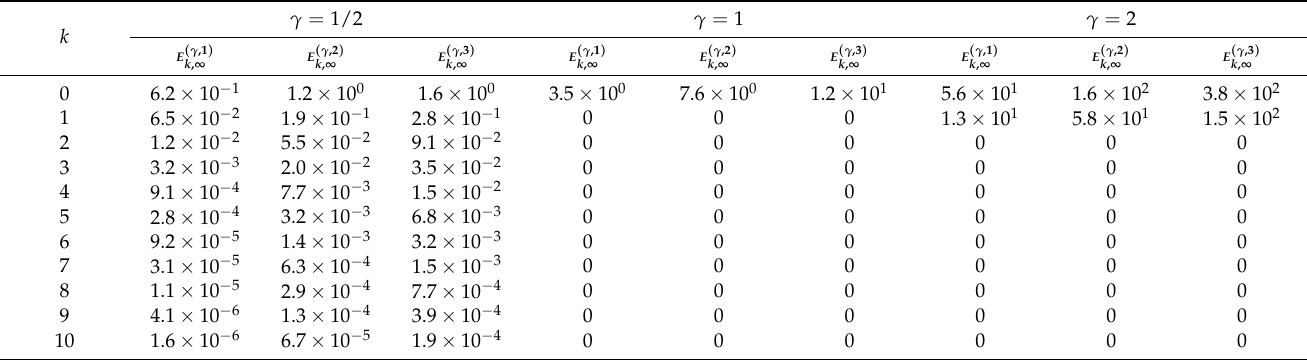
Figure 6. The variations on the approximate values of E MC simulations in Example 2 with an increasing number of sample paths, demonstrating the convergence of the approximate values obtained from MC simulations to the ones computed by using our Formula (8) with K = K 1 = 300 and K = K 2 = 400 terms in the infinite series, respectively, when the number of sample paths approaches infinity. Table 1. The truncation errors of E ( γ ,3 ) and E , respectively, computed in Example 2 by using (11) when γ = 1 k , ∞ k = 0, . . .